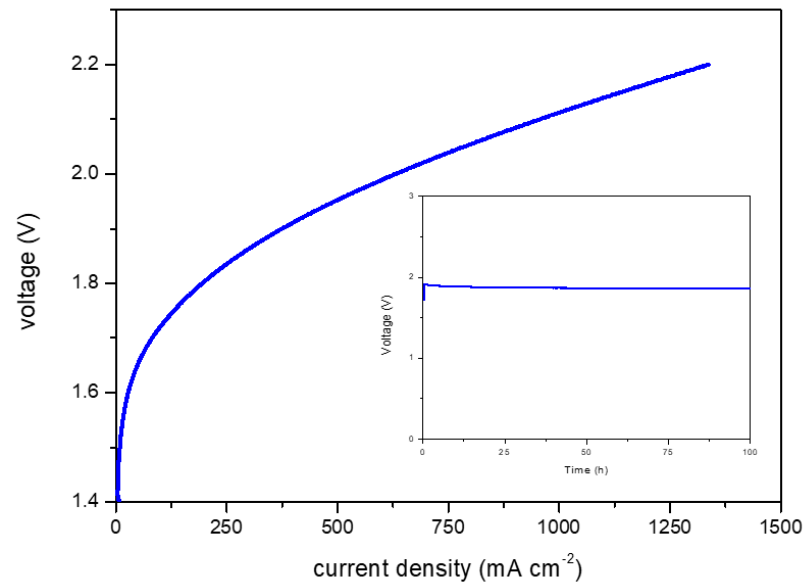
Figure 7. Performance and stability AEM electrolysis by using Ni–Fe–O x –SS anode for 1 M KOH.